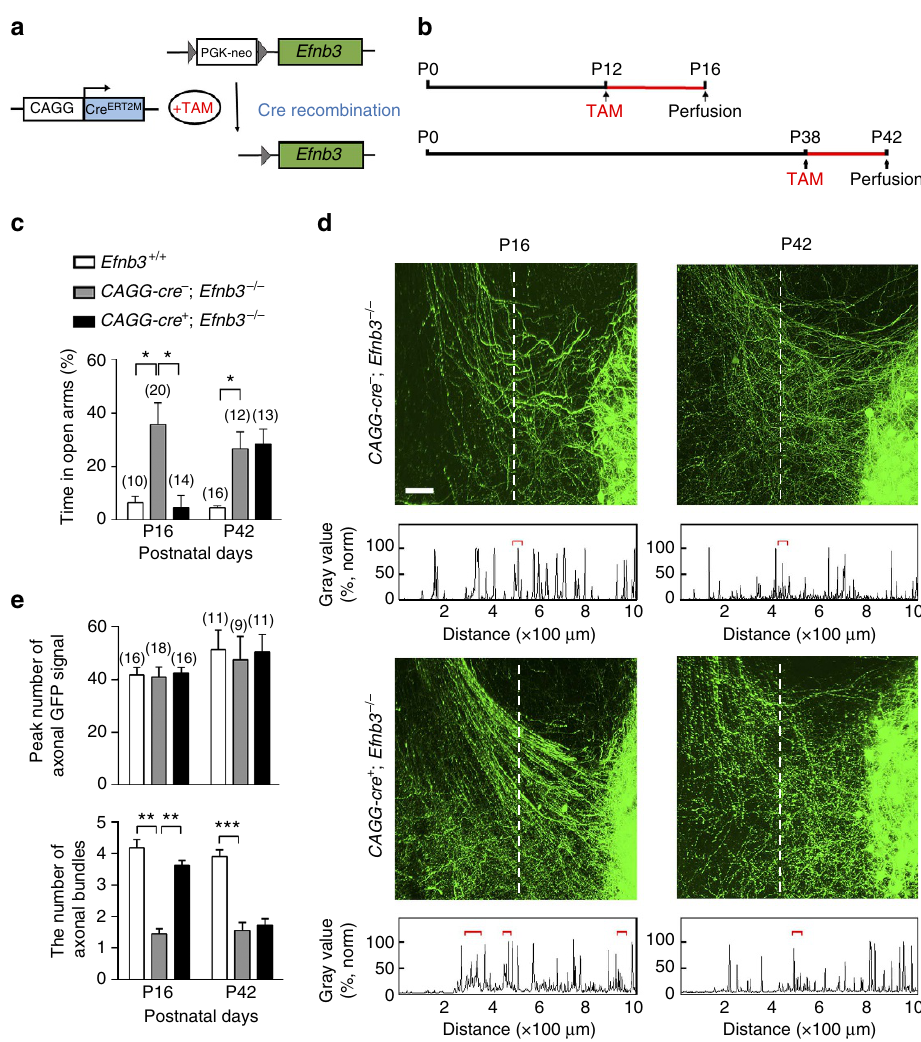
Figure 4 | Temporal-specific rescue of eB3 restores defensive responses in Efnb3 (cid:2) / (cid:2) mutant. ( a ) Transgenic mice expressing tamoxifen-inducible Cre recombinase under the control of the CAGG promoter ( CAGG-Cre ERT2M ) were crossed with Efnb3 (cid:2) / (cid:2) homozygotes. EB3 expression in the initial Efnb3 (cid:2) / (cid:2) mutant is restored on tamoxifen administration to induce Cre-mediated excision of the loxP -flanked PGK neo cassette. ( b ) Schedule of tamoxifen treatment and brain perfusion during postnatal development. All the mice including wild-type controls were treated with tamoxifen injection at the indicated time. ( c ) CAGG - Cre þ ; Efnb3 (cid:2) / (cid:2) mice showed a shorter time in EPM open arms than CAGG - Cre (cid:2) ; Efnb3 (cid:2) / (cid:2) at P16 following tamoxifen treatment at P12 but not when tamoxifen was applied at P38. The experiments were triplicated independently. n values of mice used are indicated above group bars. * P o 0.05, one-way ANOVA. ( d ) Representative images showing Thy1-GFP M-labelled axon bundles projecting into amygdala of CAGG - cre (cid:2) ; Efnb3 (cid:2) / (cid:2) and CAGG - cre þ ; Efnb3 (cid:2) / (cid:2) mice. Scale bars, 100 m m. ( e ) Quantification of the total peak number of axonal GFP signal crossing the dotted line and fasciculated axonal bundles (indicated with red square brackets). n values of brain slices from 5 to 6 mice per group are indicated above each group bar, ** P o 0.01; *** P o 0.001, one-way